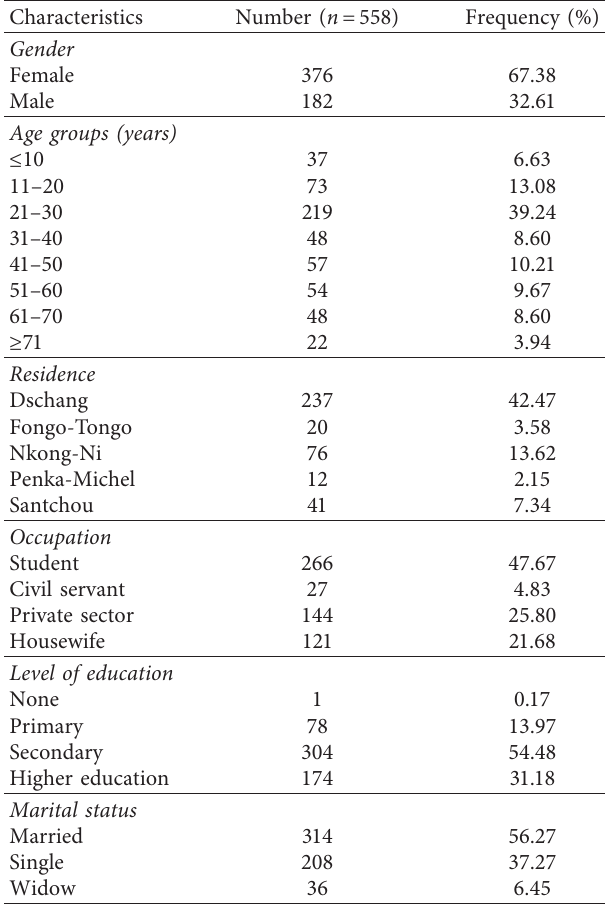
Table 1: Sociodemographic characteristics of study participants.